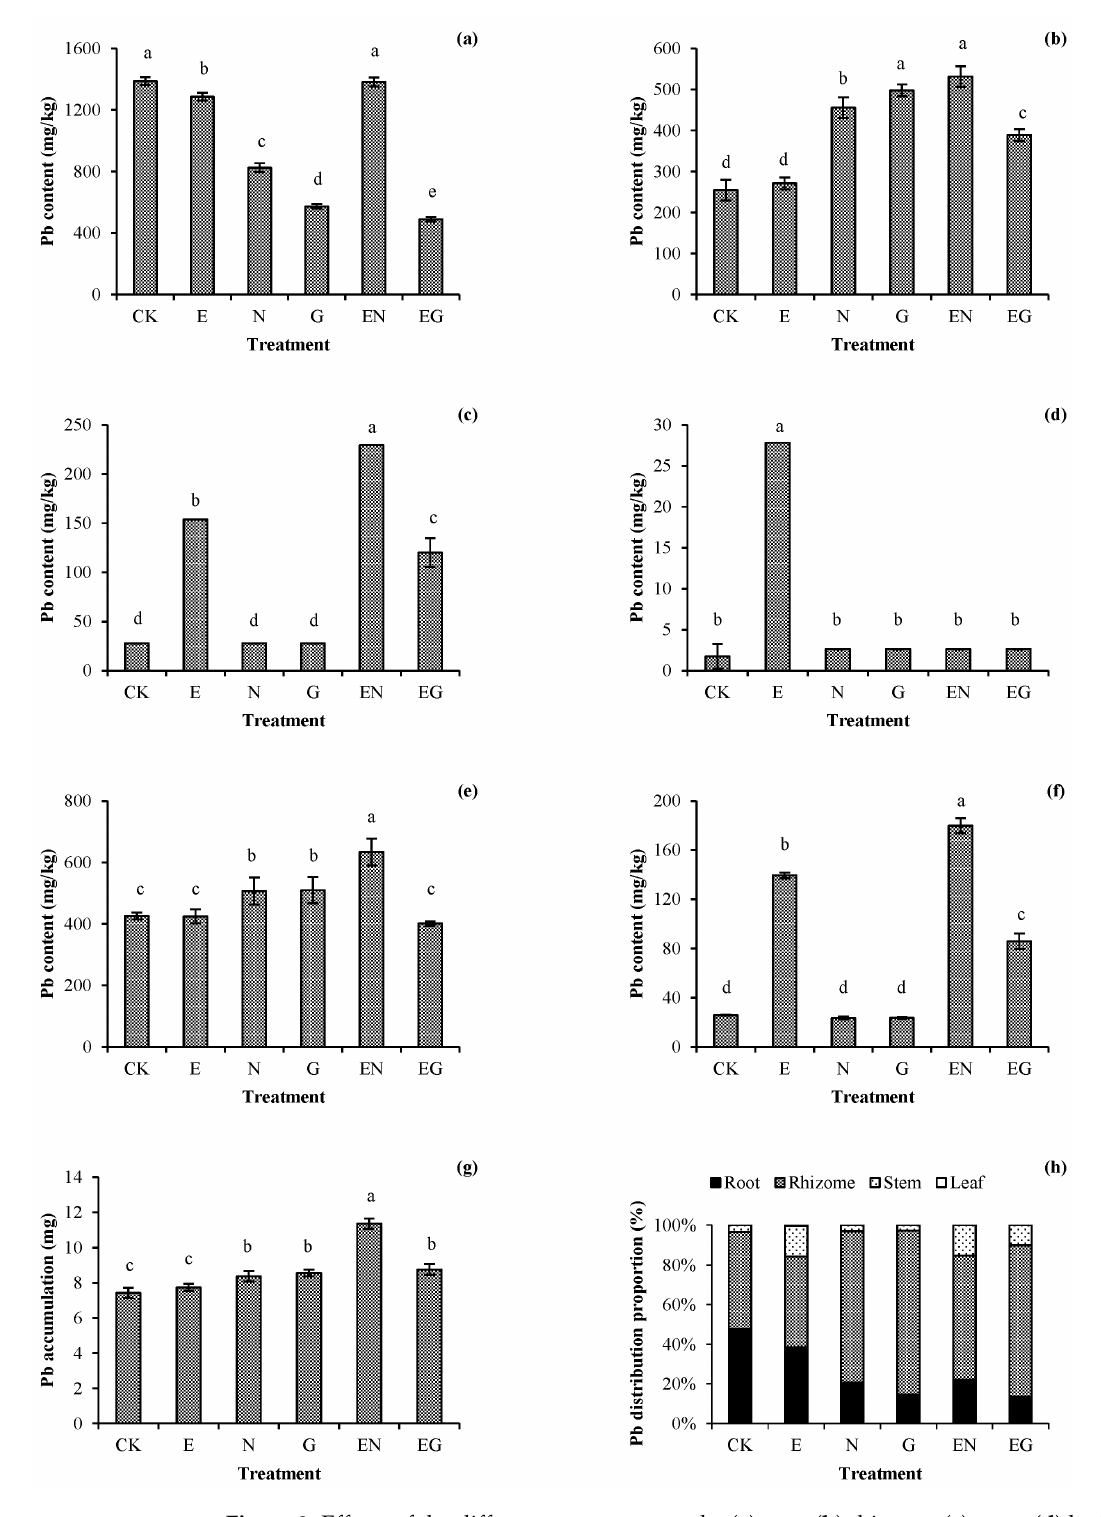
Figure 2. Effects of the different treatments on the ( a ) root, ( b ) rhizome, ( c ) stem, ( d ) leaf, ( e ) aerial- part, and ( f ) underground-part Pb concentrations; ( g ) total Pb accumulation; and ( h ) Pb distribution patterns in different tissues of dwarf bamboo. Error bars represent the standard deviations (SDs) of the means ( n = 3). According to Duncan’s multiple range test, different letters above the bars indicate significant differences ( p <